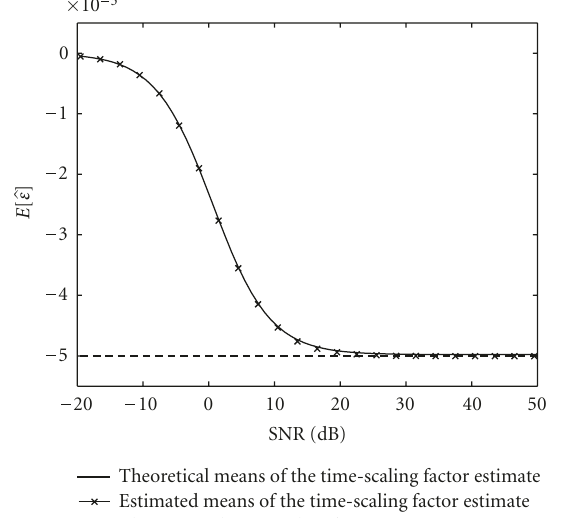
Figure 1: Theoretical and estimated means of the time-scaling fac- tor estimate. The expected time-scaling factor to estimate is plotted for each SNR. Estimated means are calculated with 1 iteration. The estimated mean is calculated on a set of 1000 independent signals with a real time-scaling factor of − 5 · 10 − 3 .